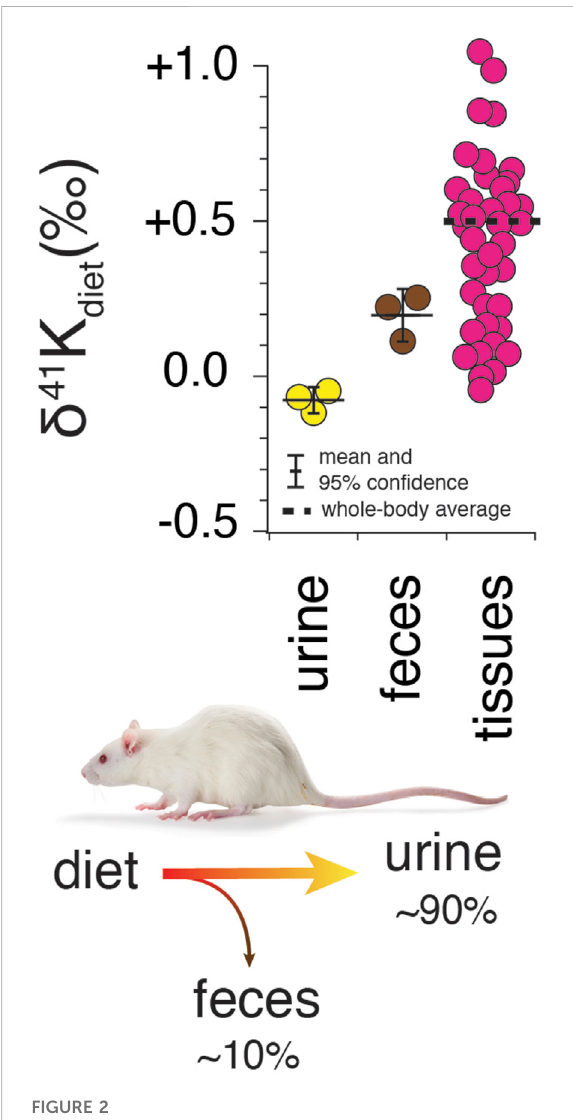
FIGURE 2 Whole-body K isotope mass balance in R. norvegicus on a controlled diet. Measured δ 41 K values of urine ( p = 0.19) and feces ( p = 0.037) relative to diet indicate a preferential uptake of 39 K in the gut. The total range in δ 41 K diet values in the tissues of R. norvegicus is ~1 ‰ with an estimated whole-body average δ 41 K diet value of approx. +0.5 ‰ , consistent with preferential loss of 39 K in